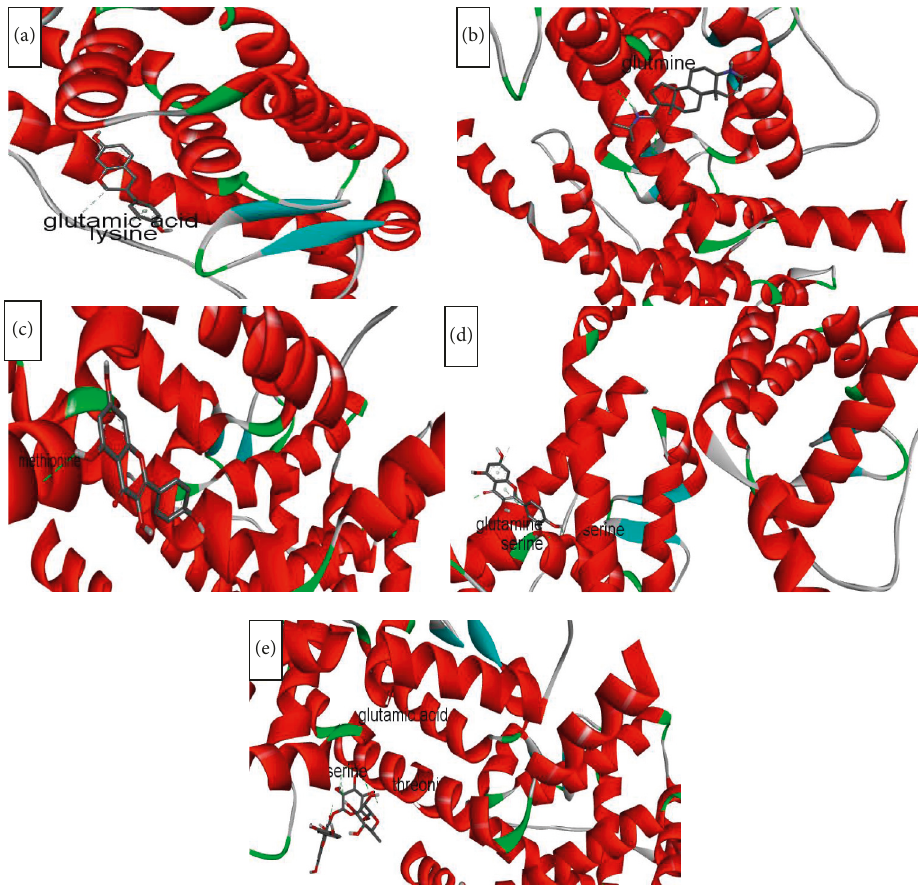
Figure 9: Interaction between amino acids in the binding site of ER-gamma enzyme, and (a) � equol, (b) � finasteride, (c) � kaempferol, (d) � quercetin, and (e) � rutin, respectively. The green bonds show intermolecular hydrogen bonds. Glutamic acid, glutamine, serine, methionine, and threonine from ER-gamma enzyme are involved in H-bond interaction with